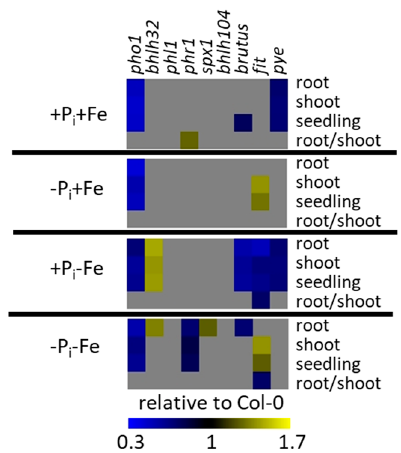
Figure 6. Root, shoot, and seedling fresh weights as well as root to shoot ratios in mutants with impaired expression of P i and Fe deficiency response regulators relative to Col-0. Grey boxes indicate no significant differences ( p ≤ 0.05, Student´s t -test, two tailed, equal variances, n ≥ 8) between mutants and Col-0. After an initial growth period of five days on nutrient sufficient conditions (+P i +Fe), seedlings were transferred to the indicated conditions and allowed to grow for an additional six days before harvest. +P i : 500 µM, − Pi: 5 µM, +Fe: 50 µM, − Fe: no Fe added. Heat maps were generated according to the data shown in Datasets S6.